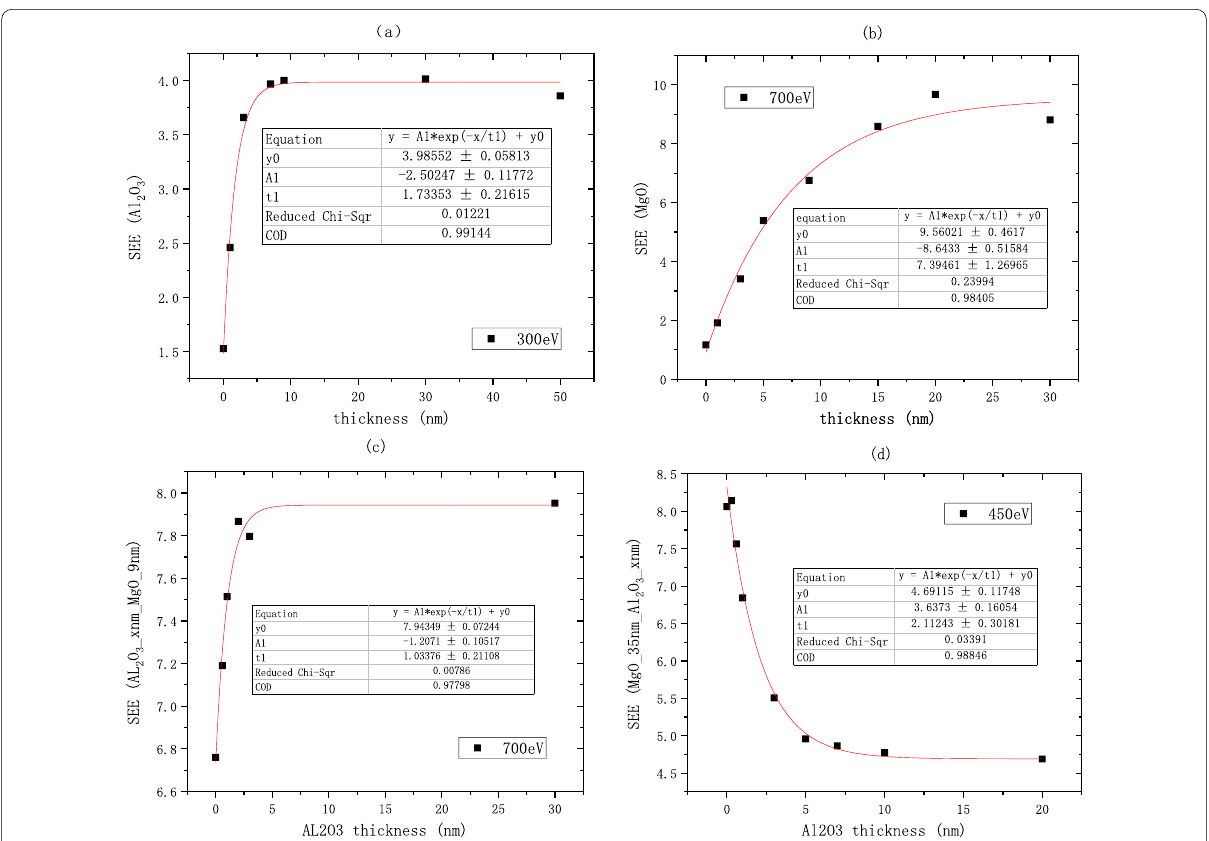
Fig.11 Relationship between the material’s best secondary electron emission coefficient and film thickness, a shows the information of Al 2 O 3 (on the silicon wafer, grow xnm-Al 2 O 3 ), b shows the information of MgO (on the silicon wafer, grow xnm-MgO), c shows the information of Al 2 O 3 / MgO (on the silicon wafer, grow xnm-Al 2 O 3 , and then grow 9 nm-MgO), and d shows the information of MgO/Al 2 O 3 (on the silicon wafer, grow 35 nm-MgO, and then grow xnm-Al 2 O 3 )